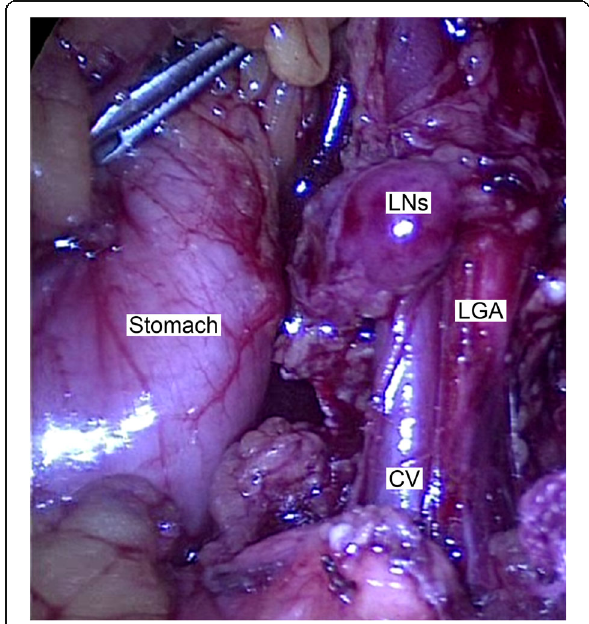
Fig. 2 Lymph nodes along the left gastric artery (group 7). LGA: left gastric artery, CV: coronary vein, LN: lymph node